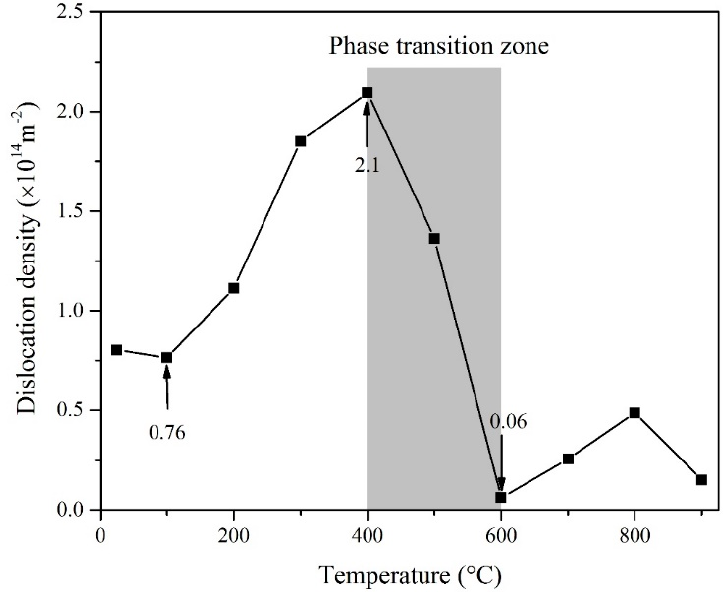
Figure 5. Dislocation density of quartz as a function of temperature.